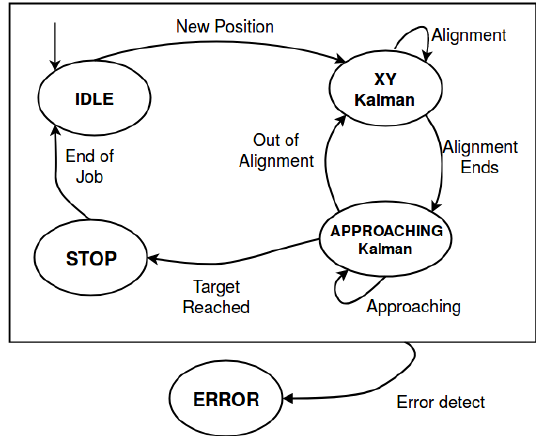
Figure 6. Finite State Machine for the control of the robotic arm end-effector